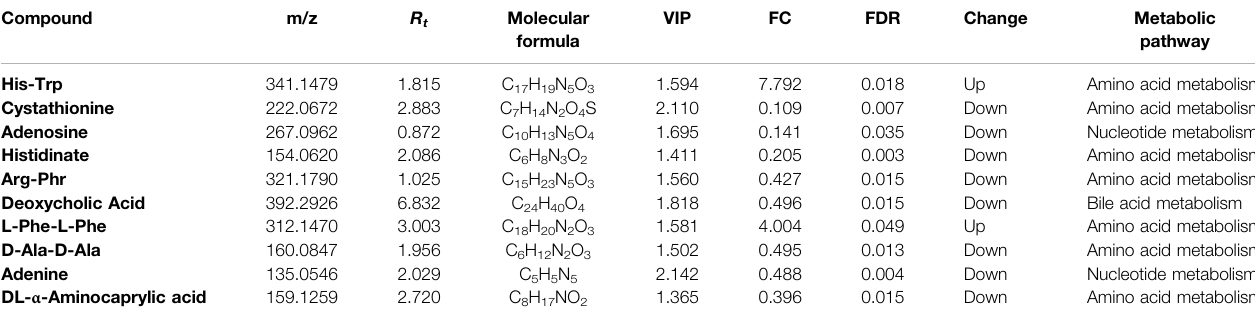
VIP FC FDR Change Metabolic formula